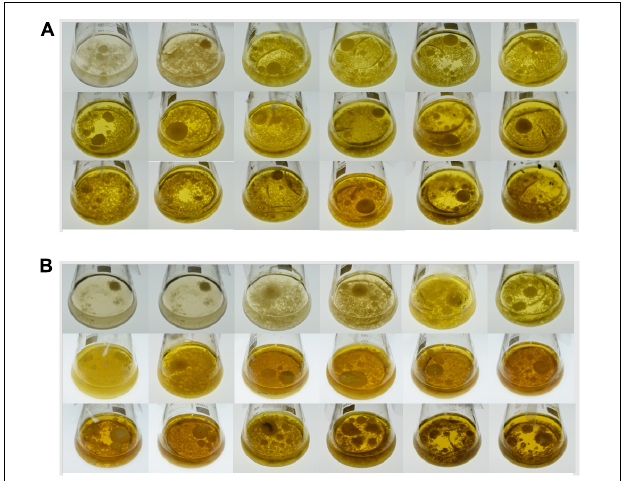
FIGURE 1 | The growth of Trichoderma longibrachiatum MD33 MeJA treatment group and control group (18 days). (A) MD33 growth in MeJA treatment group. From the third day, the color of liquid gradually deepened, from light yellow to brown, the biomass of MD33 increased significantly from the second day, in the seventh day, the biomass reached the maximum and remained basically unchanged. (B) MD33 growth in Control group. In the first 4 days, the biomass remained at a low level and the color of liquid was limpid, from the fifth day to the eighteenth day, the color gradually changed from light yellow to brown. From the eighth day, the biomass reached the